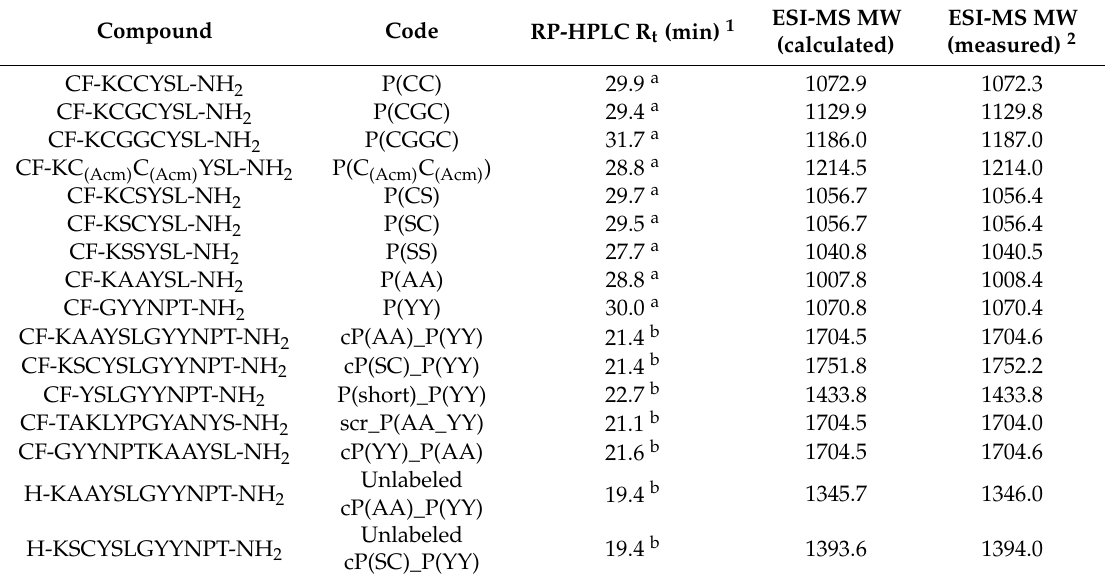
Table 1. List of HER2 binding compounds with their corresponding codes, RP-HPLC retention times, and their calculated and measured molecular